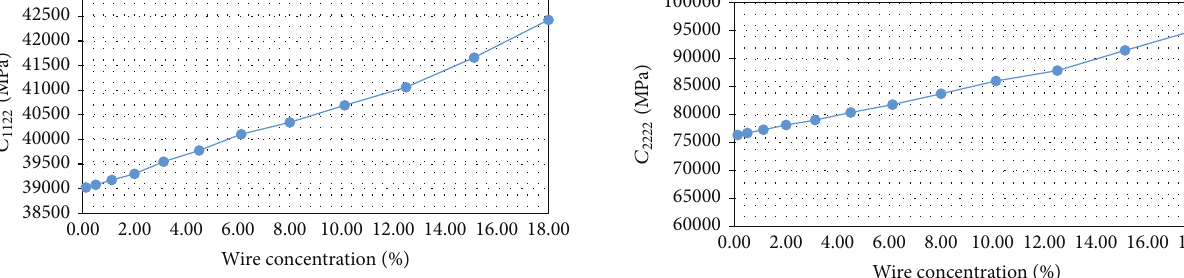
(0) 𝐶 2222 for reinforced plexiglas